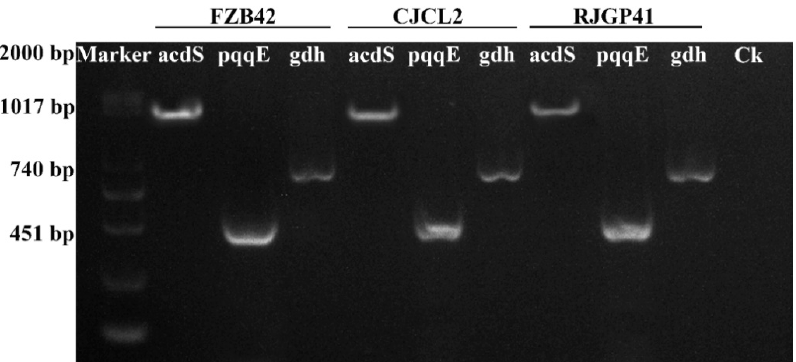
Figure 5. The biofilm formation potential of selected strains grown under cold stress (4 °C) ( A ). Biofilm formation ability of bacterial strains at optimum temperature, i.e., 37 °C (B) . The 20 × images of biofilm structures of selected bacteria grown under cold stress as well as at optimum temperature ( C ).